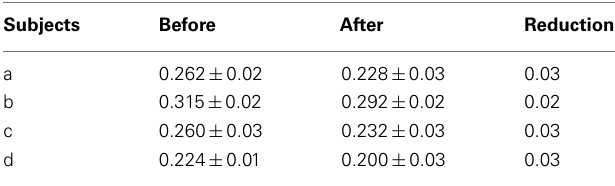
Table 1 | MSE before and after post-processing. Mean and STD of MSE over 5-fold cross-validation are shown here for each subject.